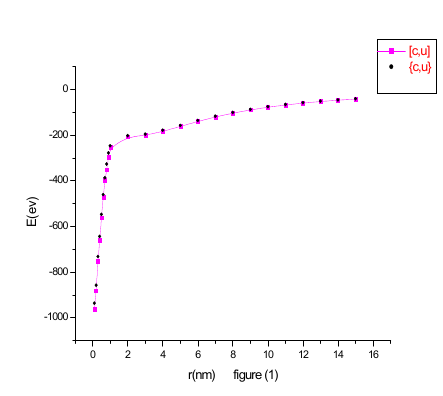
Fig. 1. Variation of Binding Energy with r_cutoff